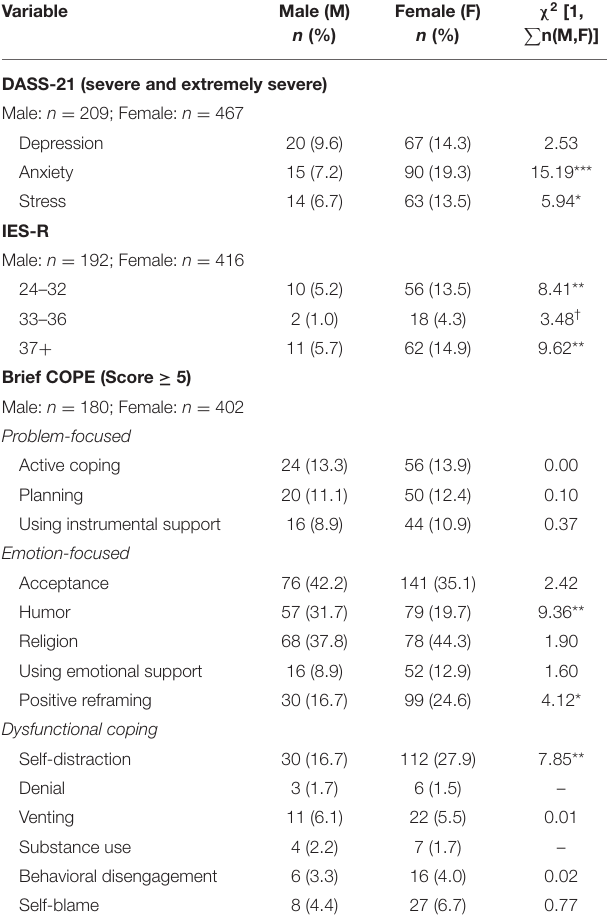
TABLE 5 | Percentages and proportions test outputs between the sexes pertaining to the DASS-21, IES-R and Brief COPE survey scales.